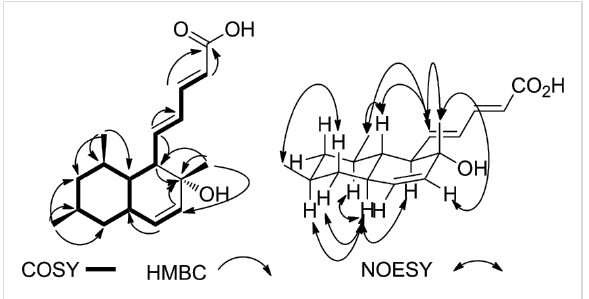
Figure 3: HMBC, COSY and NOESY correlations of compound 3 .